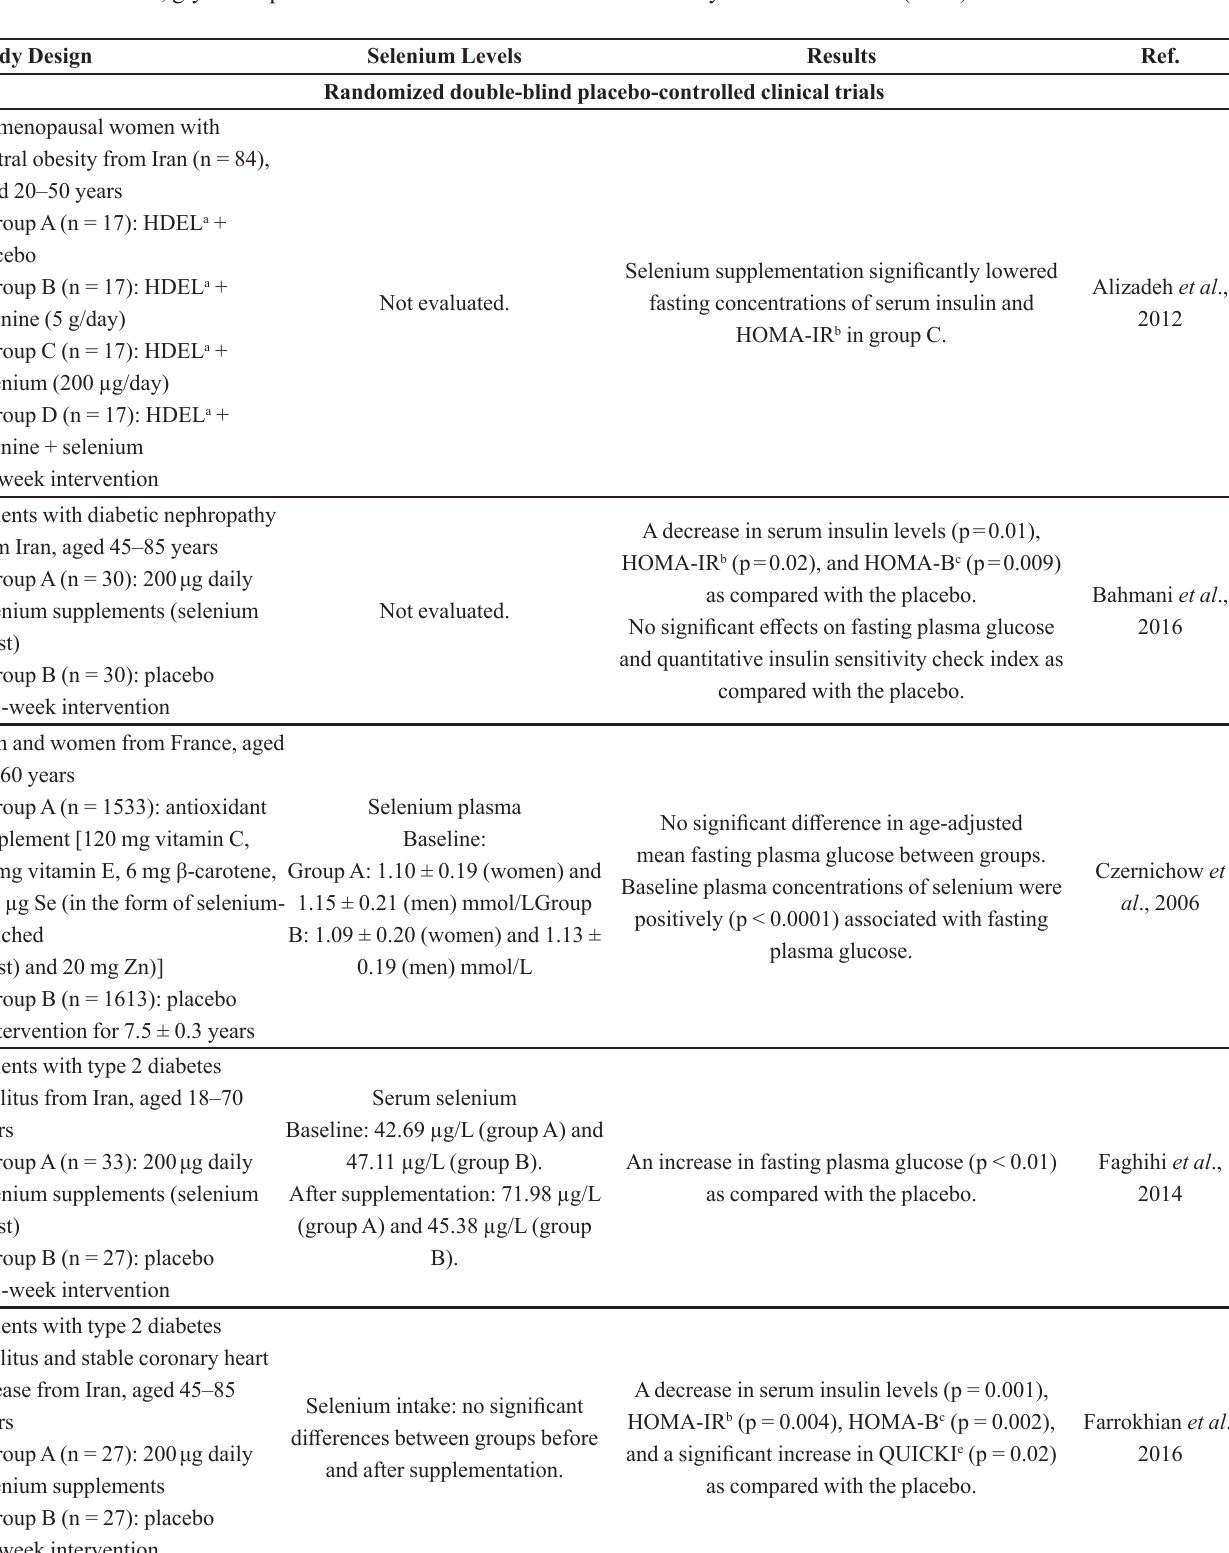
TABLE I - Selenium, glycemic parameters and insulin resistance: a summary of human studies